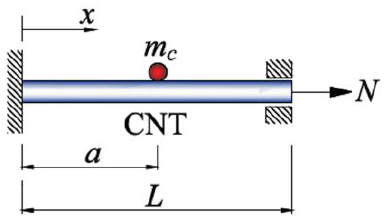
Figure 7. Schematic diagram of clamped carbon nanotube (CNT) beam model with attached mass under tensile load.